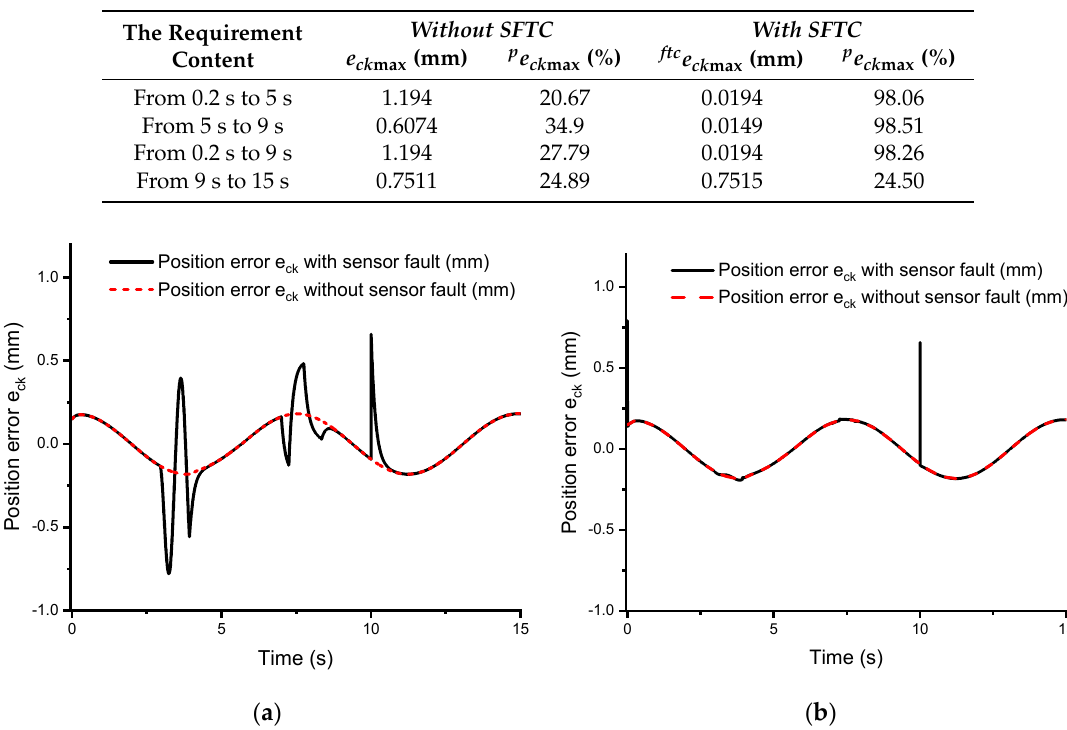
Figure 7. The position control error e ck for the case without disturbance d k of ( a ) without SFTC, and ( b ) with SFTC.